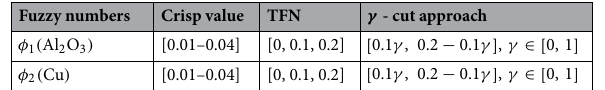
Table 2. TFNs of fuzzy nanoparticles of volume